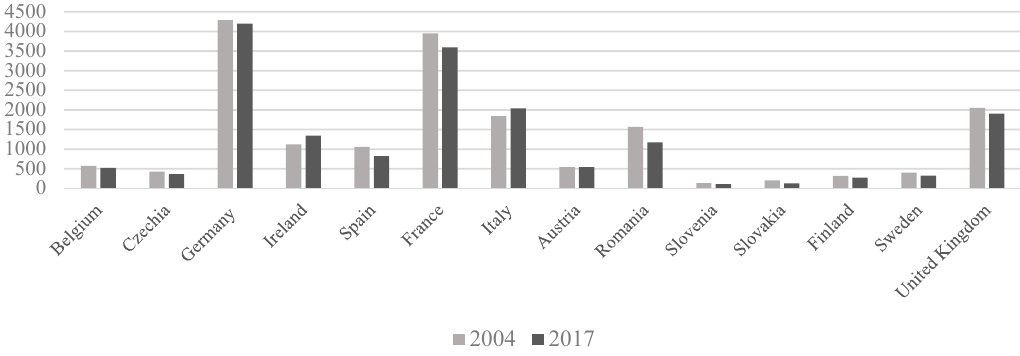
Figure 2. Development of dairy cows (thousand heads) in selected countries. Source: Eurostat.